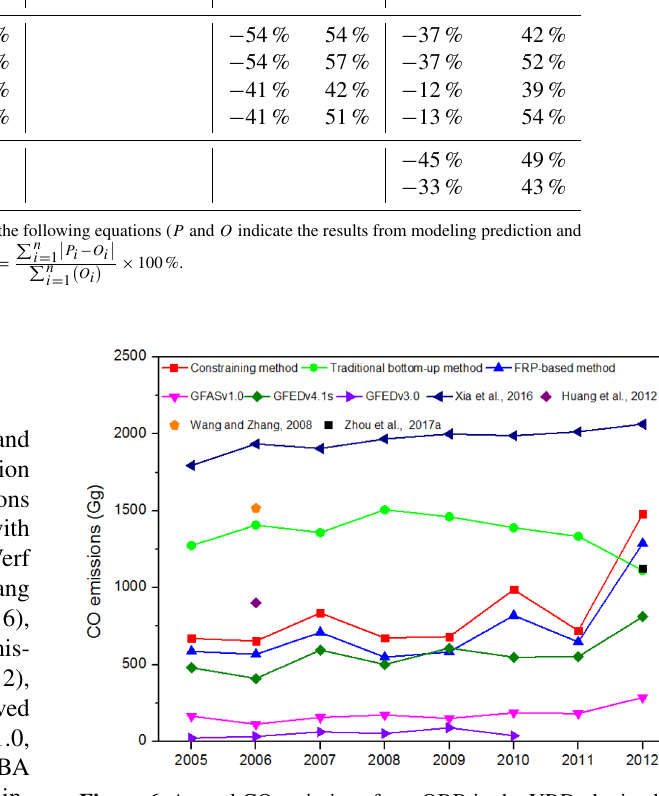
Figure 6. Annual CO emissions from OBB in the YRD obtained in this work and other studies from 2005 to